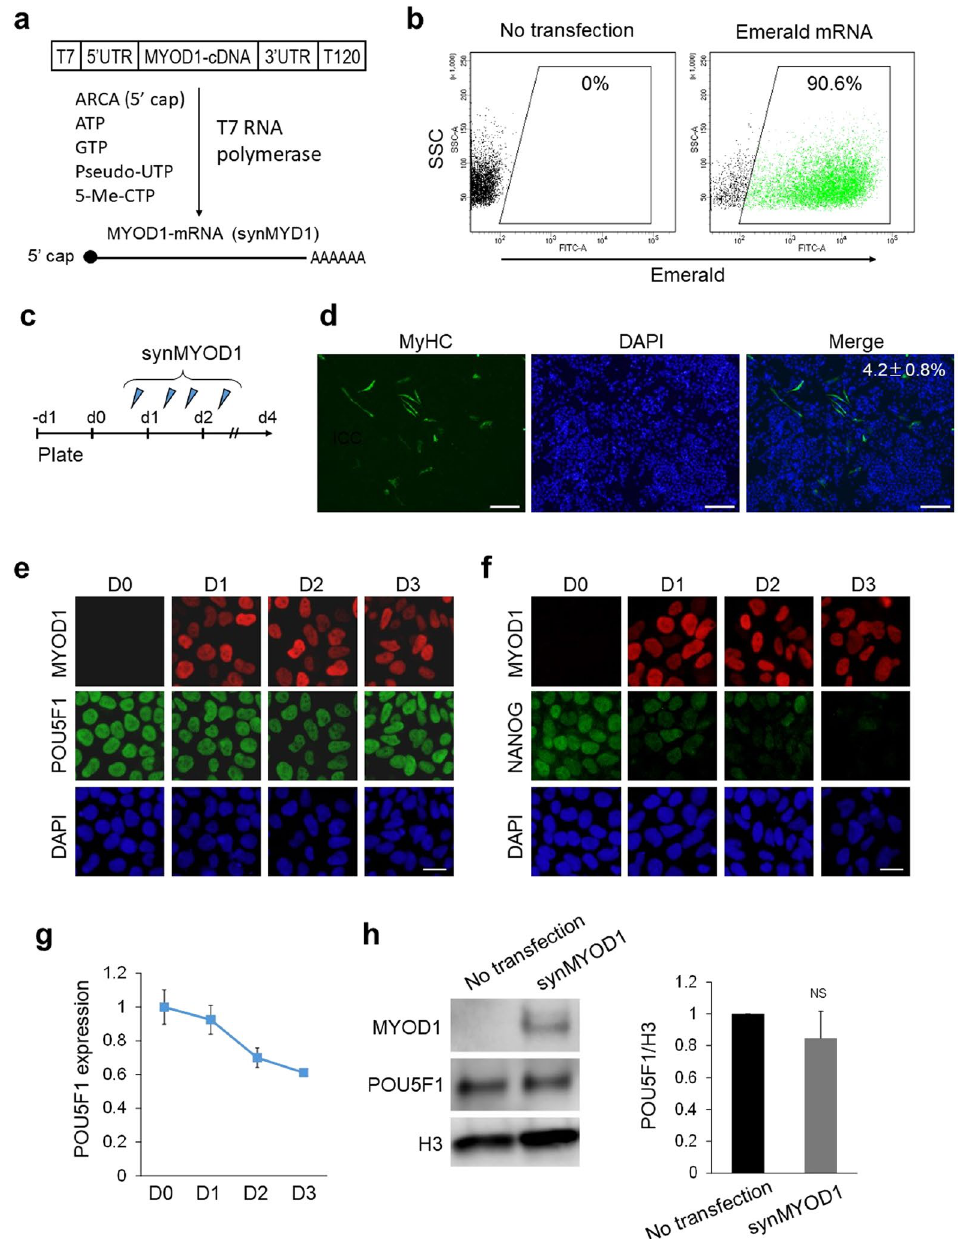
Figure 1. POU5F1 expression is stably sustained in MYOD1-mRNA (synMYOD1)-treated hESCs. ( a ) synMYOD1 was synthesized in vitro with T7 RNA polymerase. The template cDNA was flanked by 5 ′ UTR and 3 ′ UTR of alpha- globin with an oligo(T) 120 for adding a polyA tail. ARCA (5 ′ cap analog), pseudo-UTP, and 5-methyl-CTP were incorporated to increase mRNA stability and translation efficiency. ( b ) The percentage of mRNA transfection in hESCs was tested using synthetic mRNA encoding Emerald GFP by FACS analysis. ( c ) Schematic diagram of the transfection protocol. hESCs were transfected with synMYOD1 once on day 0, twice on day 1, and once on day 2. ( d ) Immunostaining analysis for MyHC in the synMYOD1-transfected cells. Nuclei were stained with DAPI. The percentage of MyHC-stained cells is shown (mean ± SEM from four independent biological replicates). Scale bar: 200 μ m. ( e ) Immunostaining analysis for POU5F1 in the synMYOD1-transfected cells at day 0 to day 3 post transfection. MYOD1 was detected by a MYOD1 specific antibody. Nuclei were stained with DAPI. Scale bar: 10 μ m. ( f ) Immunostaining analysis for NANOG in the synMYOD1-transfected cells at day 0 to day 3 post transfection. MYOD1 was detected by the specific antibody. Nuclei were stained with DAPI. Scale bar: 10 μ m. ( g ) qRT-PCR analysis for POU5F1 expression day 0 to day 3 after transfection (mean ± SEM from two independent biological replicates). ( h ) Immunoblotting analysis for POU5F1 in the synMYOD1-transfected cells at day 3 post transfection. MYOD1 was detected by the specific antibody. The H3 antibody was used as a loading control. The relative intensities of POU5F1 signals normalized by H3 were compared between no transfection and synMYOD1 transfection (mean ± SEM from three independent biological replicates). NS: not significant. Uncropped images of the blots for Fig. 1h are shown in Supplementary Figure